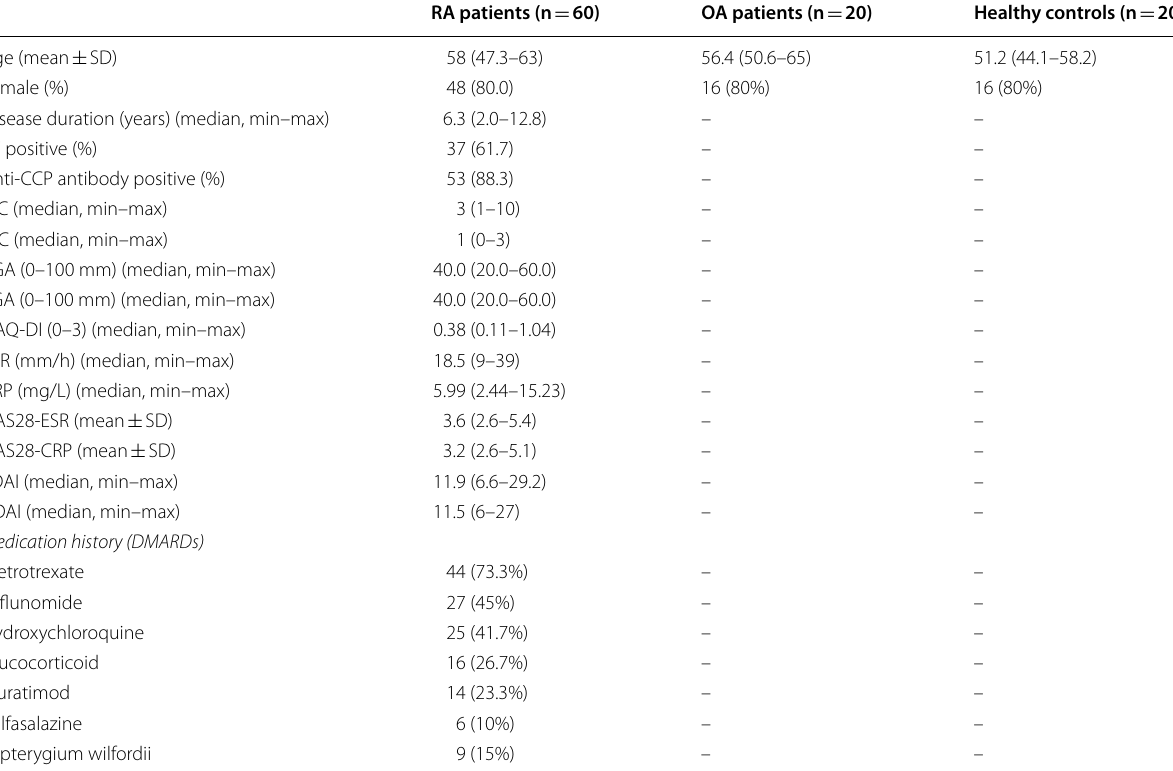
Table 1 The baseline demographic and clinic features of 60 RA patients